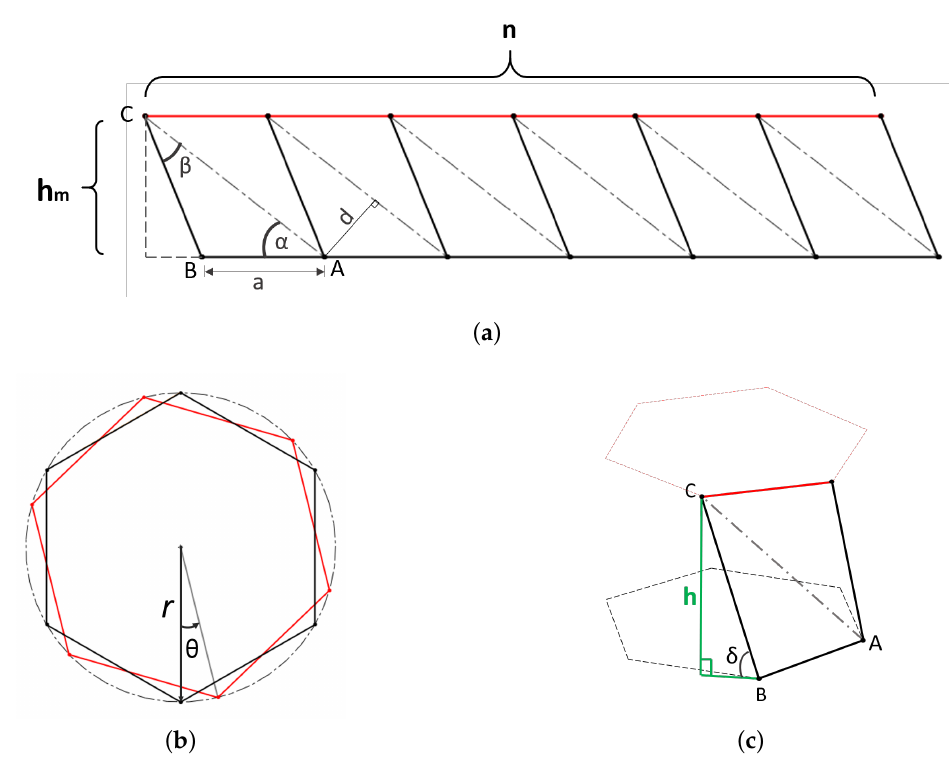
Figure 1. Origamipolyhedron Kresling pattern. ( a ) 2D Kresling pattern. ( b ) Folded cylinder link state. ( c ) Biestable